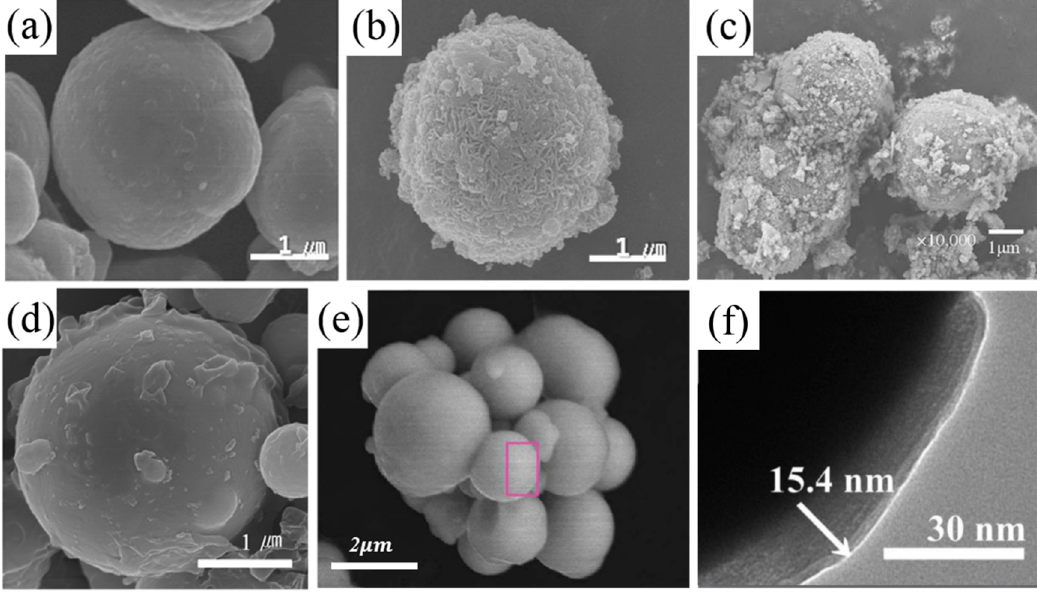
Figure 2. SEM image of ( a ) pure carbonyl iron (CI), ( b ) CI/(3-aminopropyl) triethoxysilane (APTES) ( c ) CI / poly(methyl methacrylate) (PMMA) [59], ( d ) CI / poly(glycidyl methacrylate) (PGMA) [60], [58], ( c ) CI/poly(methyl methacrylate) (PMMA) [59], ( d ) CI/poly(glycidyl methacrylate) (PGMA) [60], ( e ) CI / poly(fluorostyrene) [61], ( f ) CI / poly(trimethylsilyloxyethyl methacrylate) (PHEMATMS) ( e ) CI/poly(fluorostyrene) [61], ( f ) CI/poly(trimethylsilyloxyethyl methacrylate) (PHEMATMS) [62].